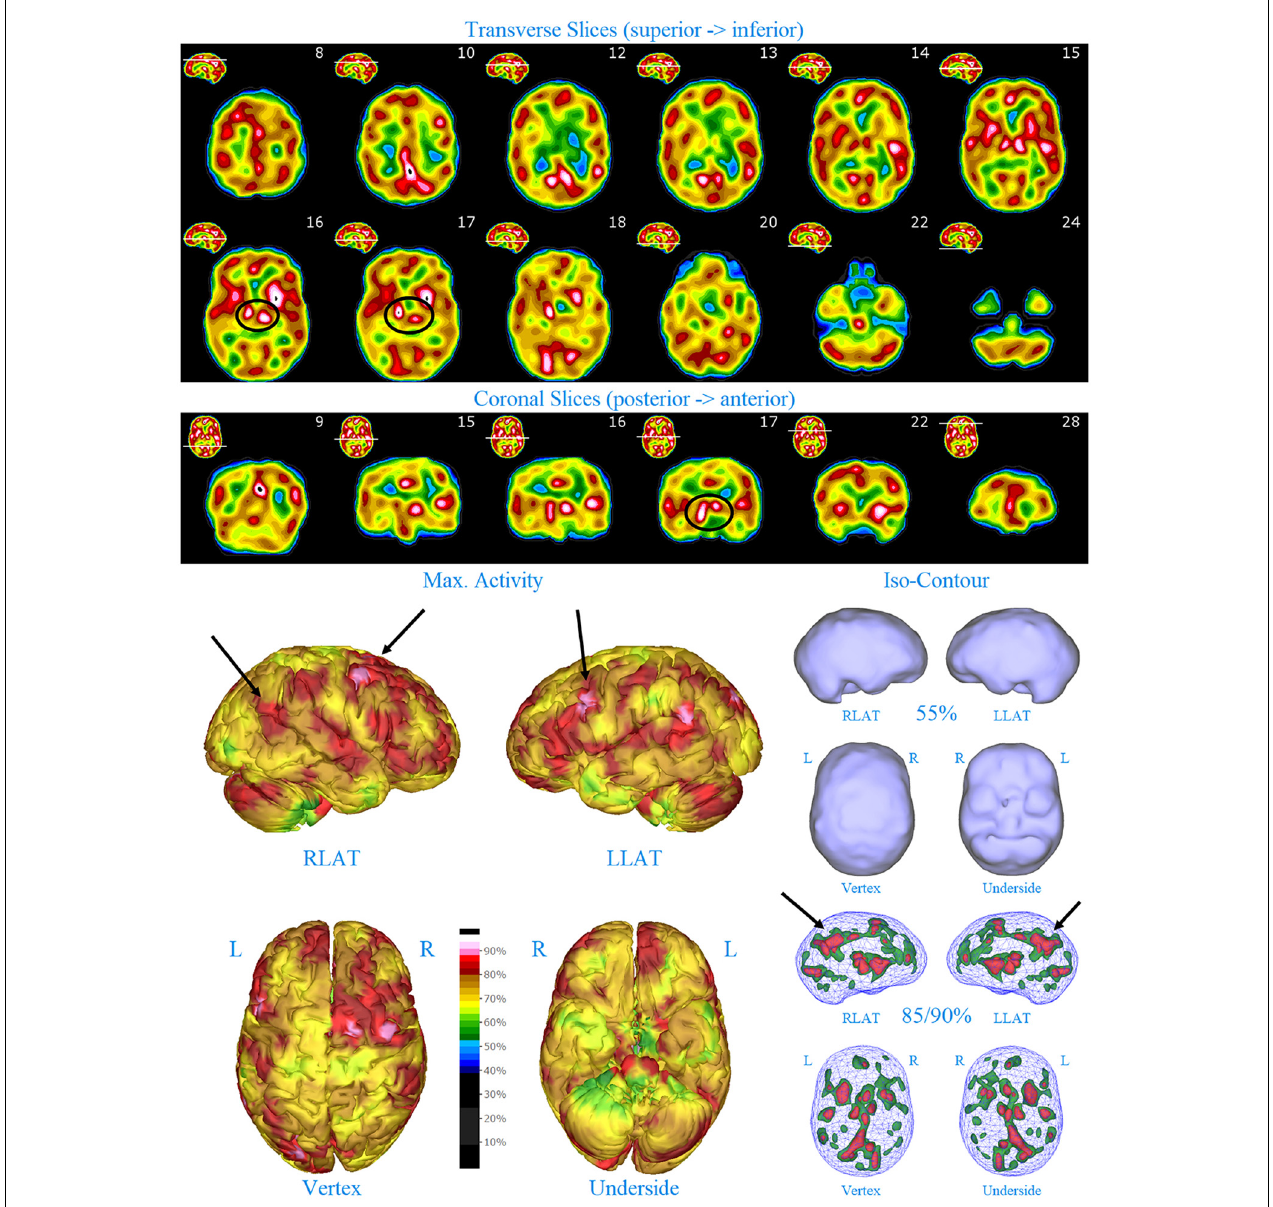
FIGURE 2 | Perfusion SPECT scan of Patient A. Arrangement, color scales, and views are identical to Figure 1 . Perfusion of the thalamus is increased and asymmetrical (circled in horizontal and coronal tomograms). Perfusion also is increased in the basal ganglia, particularly on the left (above and to the right of the encircled thalamus). Multiple areas of increased perfusion are seen throughout the cerebral cortices in both the 3-dimensional reconstruction and the wireframe isocontour representations (arrows). The frontal lobe on the right show more substantial increases in cerebral